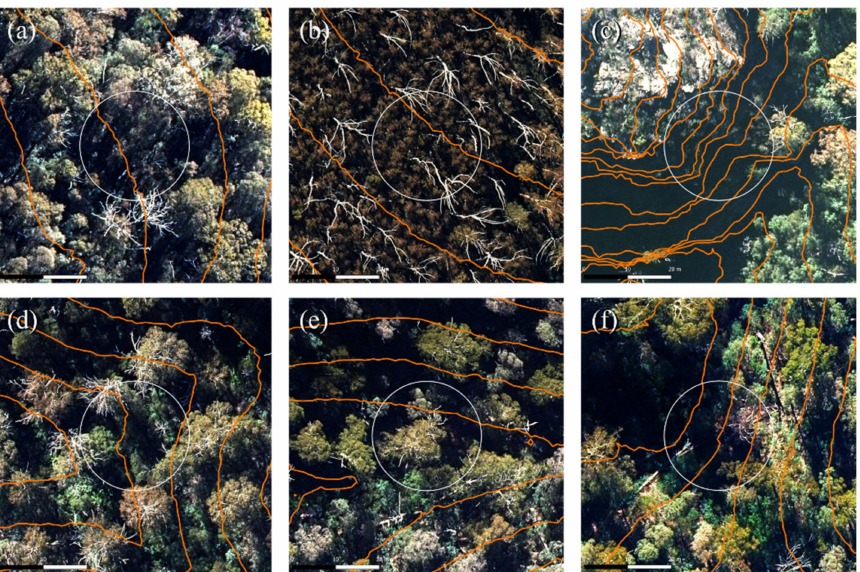
Figure 9. Six example outliers with a large deviation of GEDI RH95 from true RH95. These were randomly selected from all observations from the Canberra site that deviated more than 20 m from the benchmark value. The GEDI footprint is represented by a white circle, the orange lines represent terrain contours in 5 m vertical intervals. ( a , b ) show examples of dead-standing trees, whereas in ( c – f ) steep slopes and gaps in the canopy are likely reasons for large RH95 residuals. High resolution aerial photography (0.1 m) shown to aid investigation, reprinted with permission from Jacobs Group Australia Pty Ltd